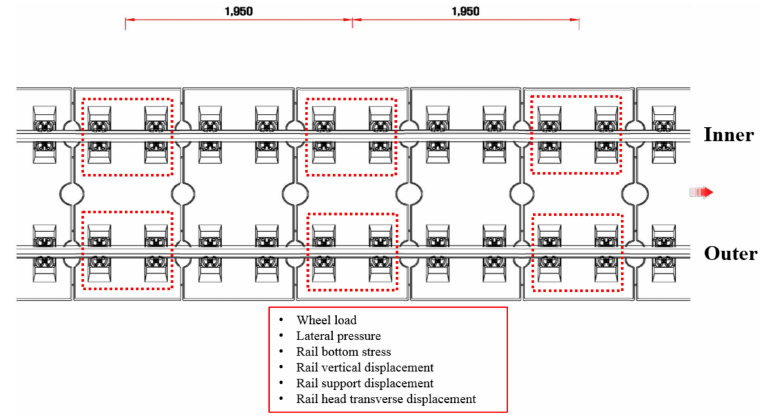
Figure 3. Location of sensor